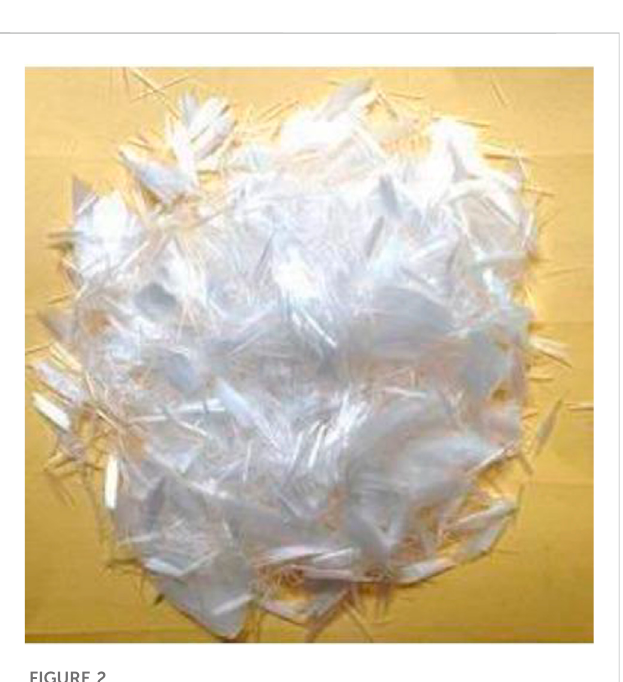
FIGURE 2 Type of PP fi bre sample